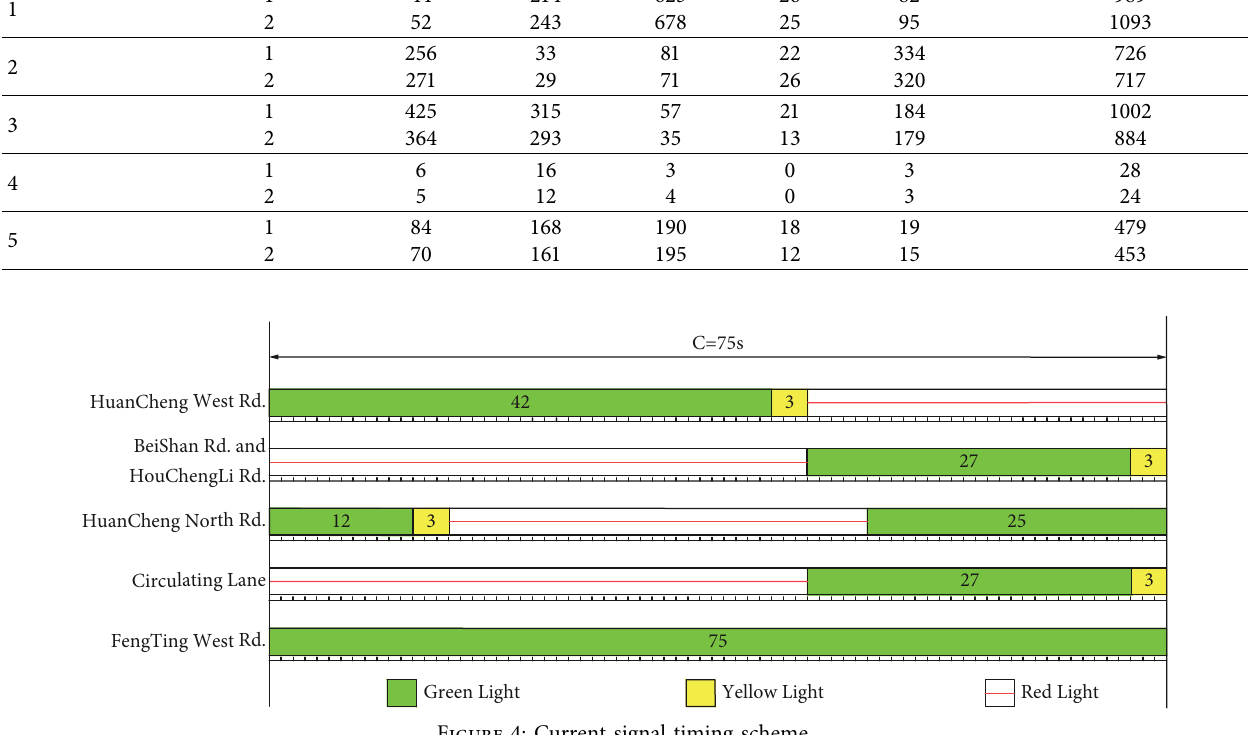
Figure 4: Current signal timing